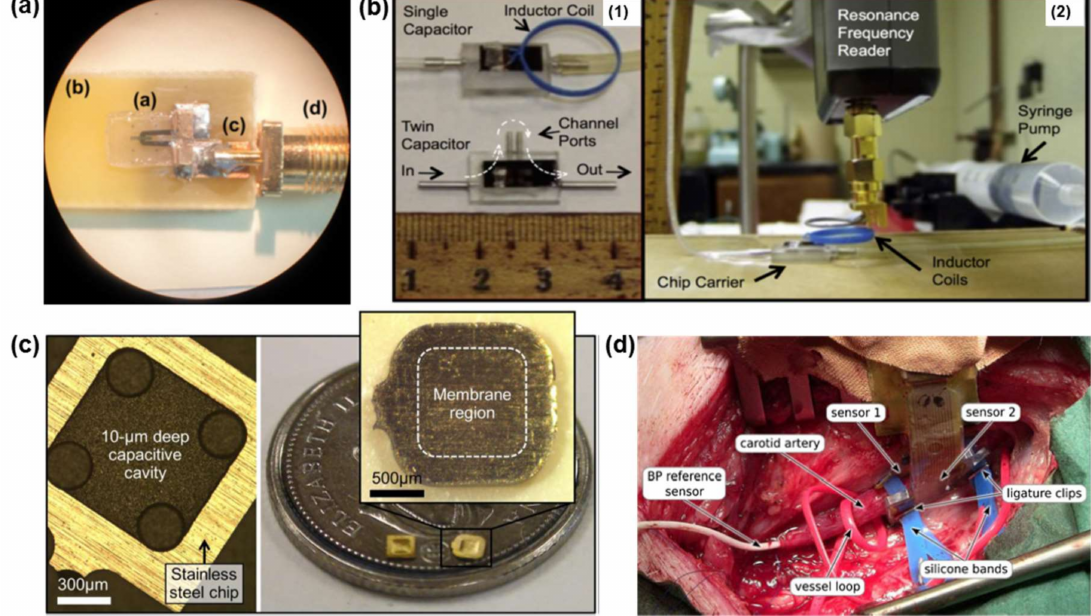
Figure 1. ( a ) Assembled blood pressure sensing device; ( a ) pressure sensor on, ( b ) FR-4 test board